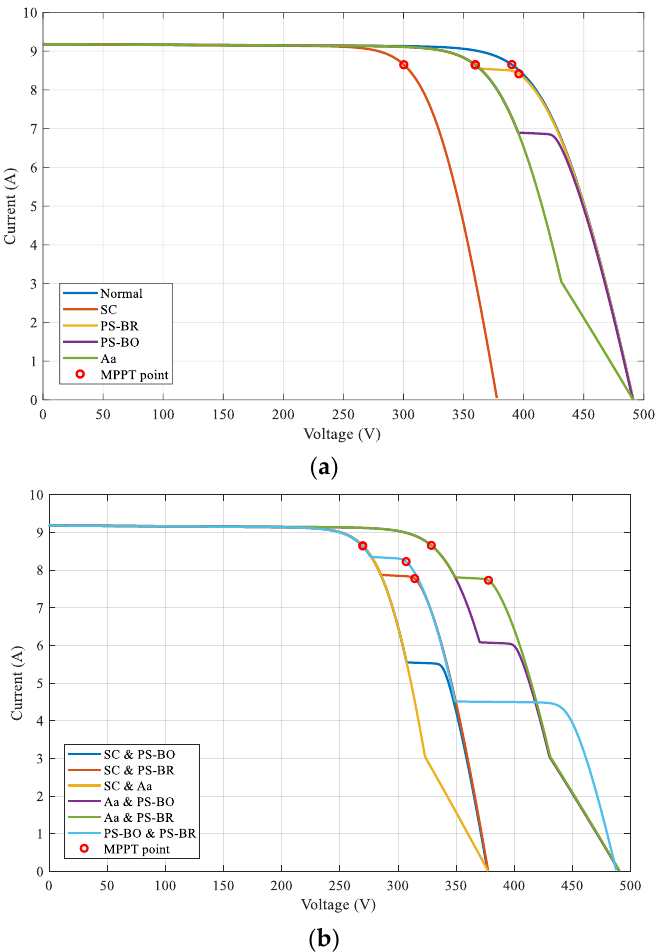
Figure 1. Characteristics of the I - V curve in different states under STC. ( a ) Single fault states; ( b ) Multiple-fault